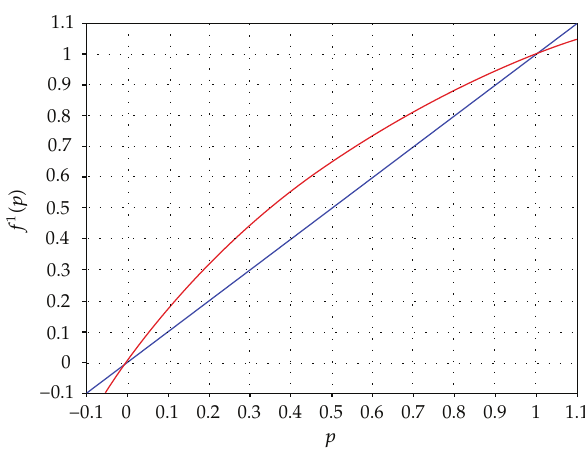
Figure 2: Phase diagram. Replicator dynamics—Example